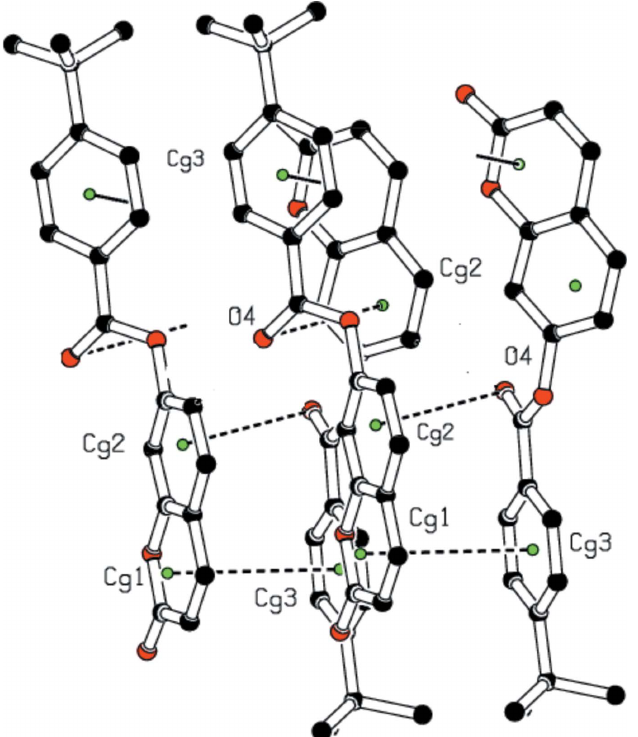
Figure 4 Aview of the crystal packing, showing H (cid:2)(cid:2)(cid:2) H contacts, C10 O4 (cid:2)(cid:2)(cid:2) (cid:2) and (cid:2) – (cid:2) stacking interactions (dashed lines). The green dots are ring centroids. H atoms not involved in H (cid:2)(cid:2)(cid:2) H interactions have been omitted for